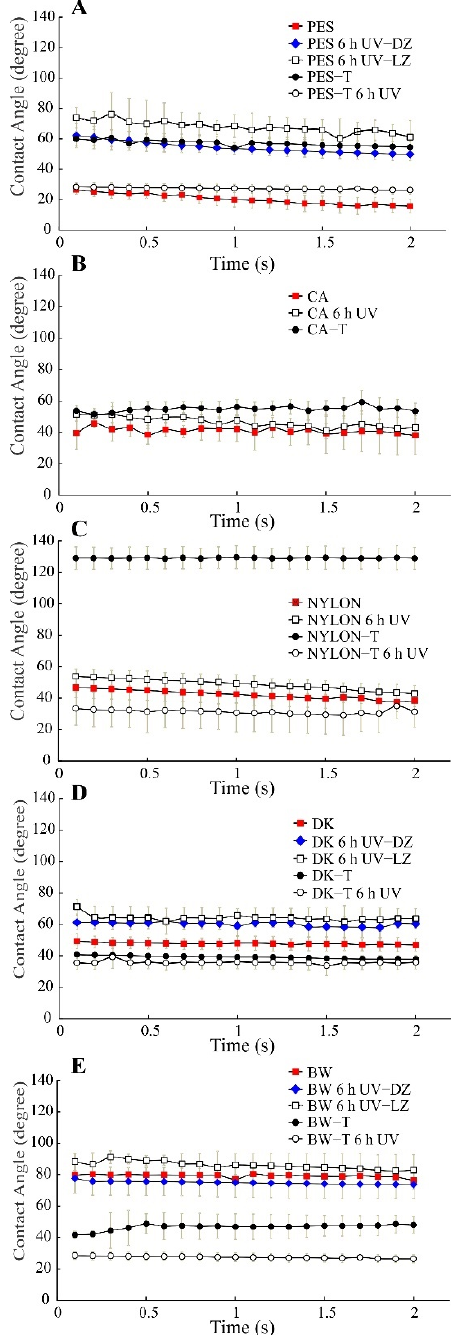
Figure 9. Water contact angle for unmodified and modified polymeric membranes (sol–gel modifi- cation with TiO 2 nanoparticles) before and after UV exposure, n = 3. ( A ) PES membranes, ( B ) CA membranes, ( C ) NYLON membranes, ( D ) DK membranes and ( E ) BW membranes. Non-modified membranes: Polyethersulfone (PES, 0.2 µm), Cellulose Acetate (CA, 0.45 µm), Polyamide–Nylon (NYLON, 0.45 µm), DK and BW30; and modified membranes: PES-T, CA-T, NYLON-T, DK-T, and BW-T. DZ = dark zone, LZ = light zone. Note: For an irradiated CA-T membrane, it was impossible to measure after UV exposure due to the instantaneous water drop spreading at the membrane sur- face.